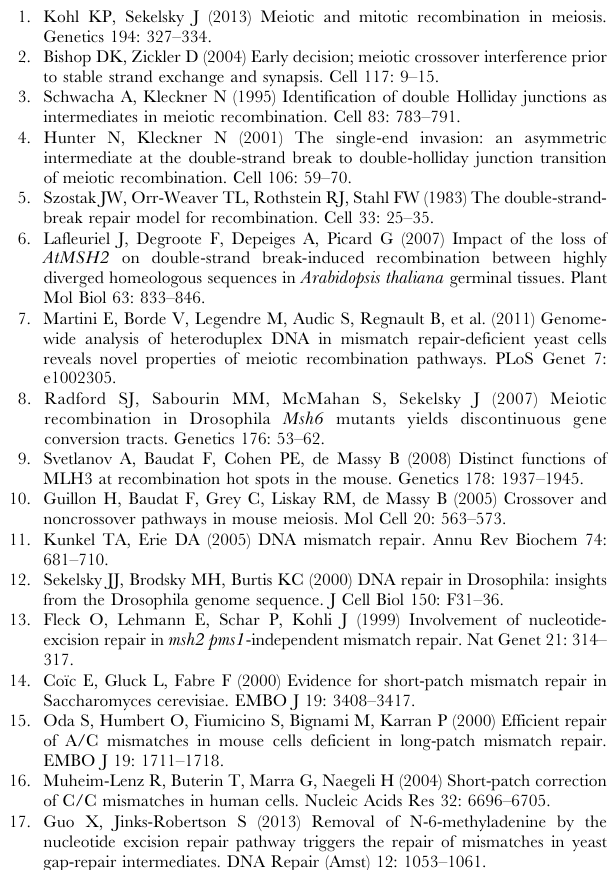
Table S1 Polymorphisms between ry 531 and ry 606 used as markers to map hDNA. Positions are relative to an Eco RI site in the coding region (3R:8,859,890 on the genome assembly release 5.44). The ry 606 mutation is at 2 468 (bold), and the ry 531 is at 3312